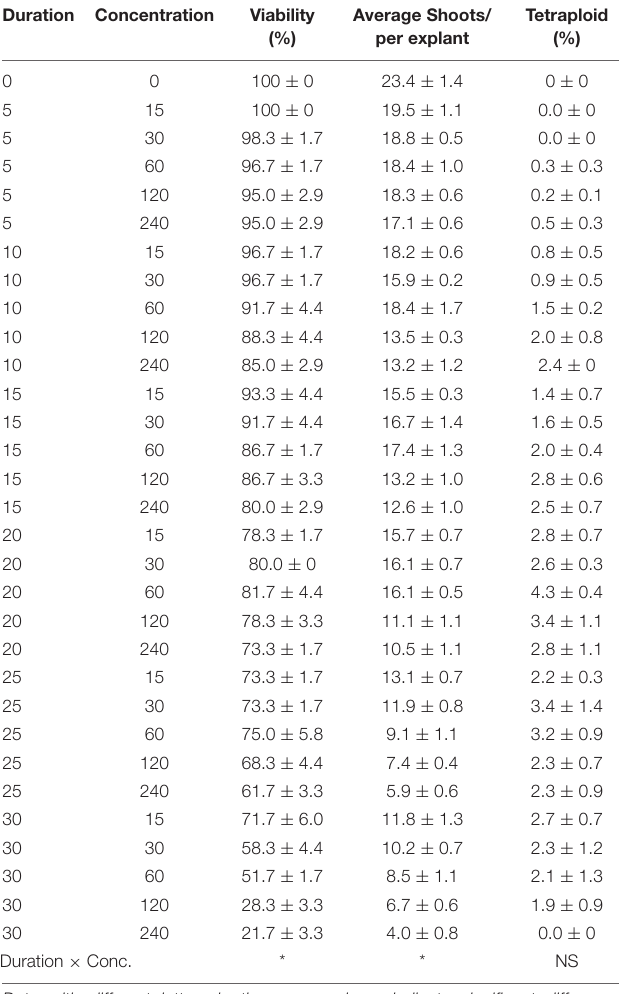
Data with different letters in the same column indicate significant difference between means at the 5% probability level by LSD. *Indicates significant difference at 0.05 level (ANOVA and LSD’s multiple range test).